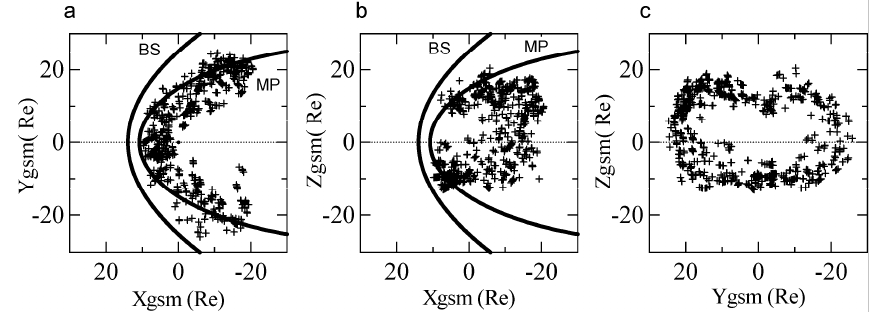
Fig. 5. The locations of FTEs in the GSM X-Y, X-Z and Y-Z planes. Events can be observed throughout the full range of locations surveyed by Interball-1.